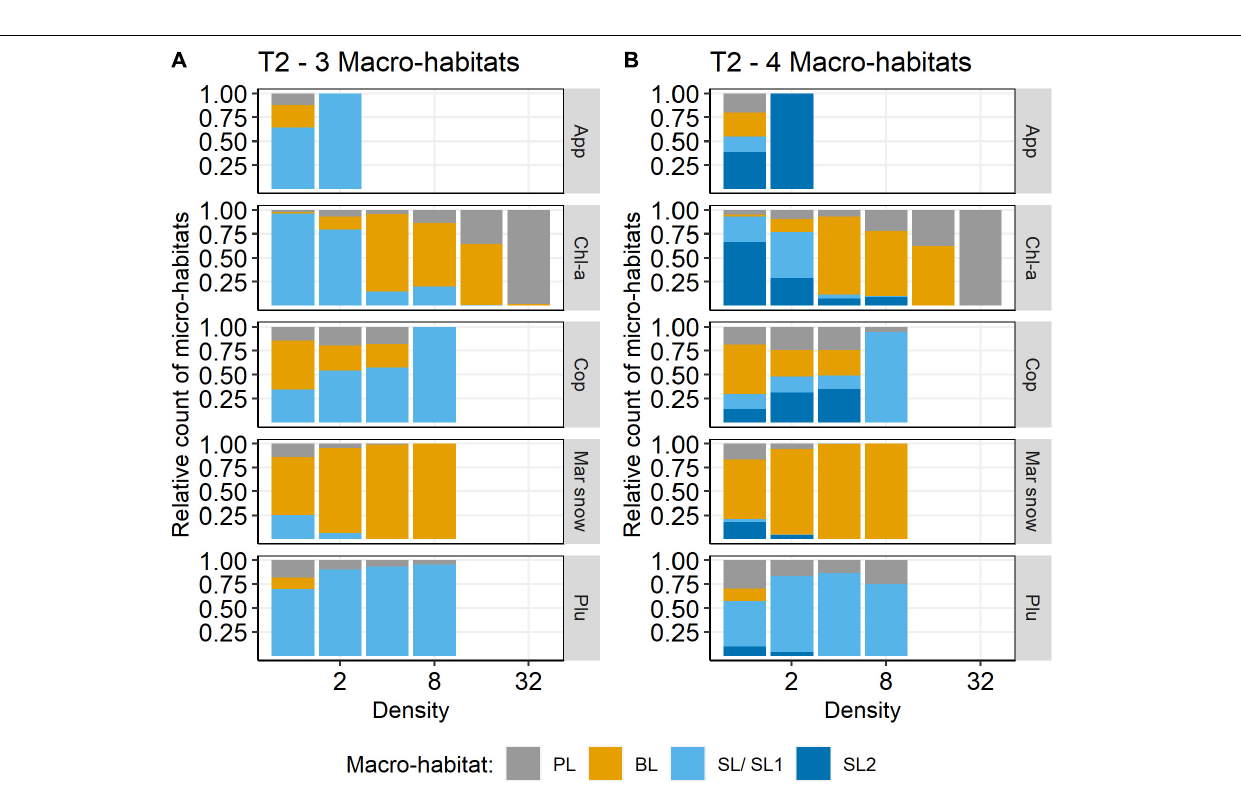
FIGURE 7 | Relative count of density by macro-habitat for selected species on transect T2 (HE429). (A) 3 macro-habitats, (B) 4 macro-habitats. App, Appendicularia (N l − 1 ); Chl-a, chlorophyll-a (RFU); Cop, Copepoda (N l − 1 ); Mar snow, marine snow (N l − 1 ); Plu, pluteus (N l − 1 ).